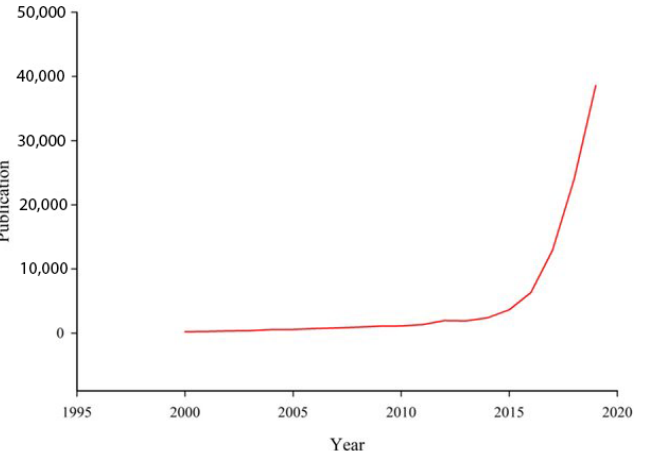
Figure 1. Published manuscripts that use the deep learning approach in medical health informatics.